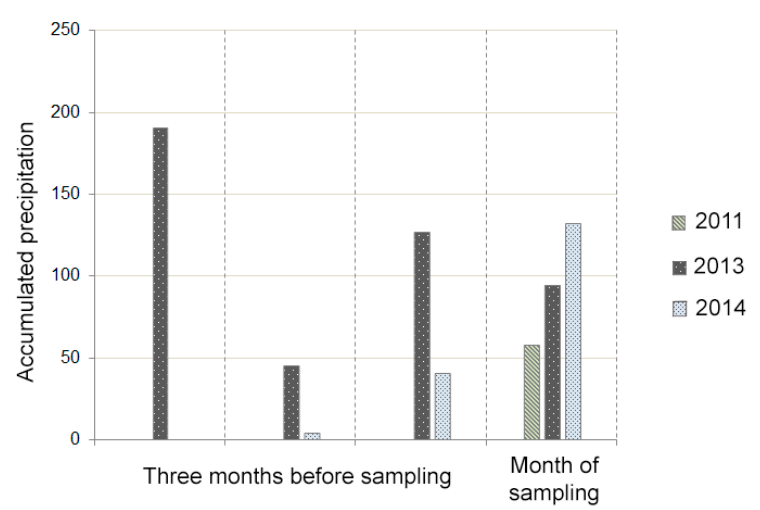
Figure 12. Cumulative rainfall (mm) in the three months prior to each sampling, including the sampling month (accumulated precipitation is measured in mm).